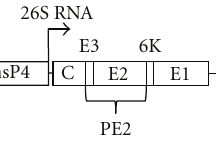
Figure 1: Alphavirus genome. The alphavirus genome is single- stranded, positive-sense RNA, encoding two open reading frames. The nonstructural proteins are translated from the genomic RNA while the structural proteins are translated from subgenomic 26S RNA (promoter as indicated). The two polyproteins are cleaved by viral cysteine, and host proteases to generate the individual protein products. ∗ denotes leaky stop